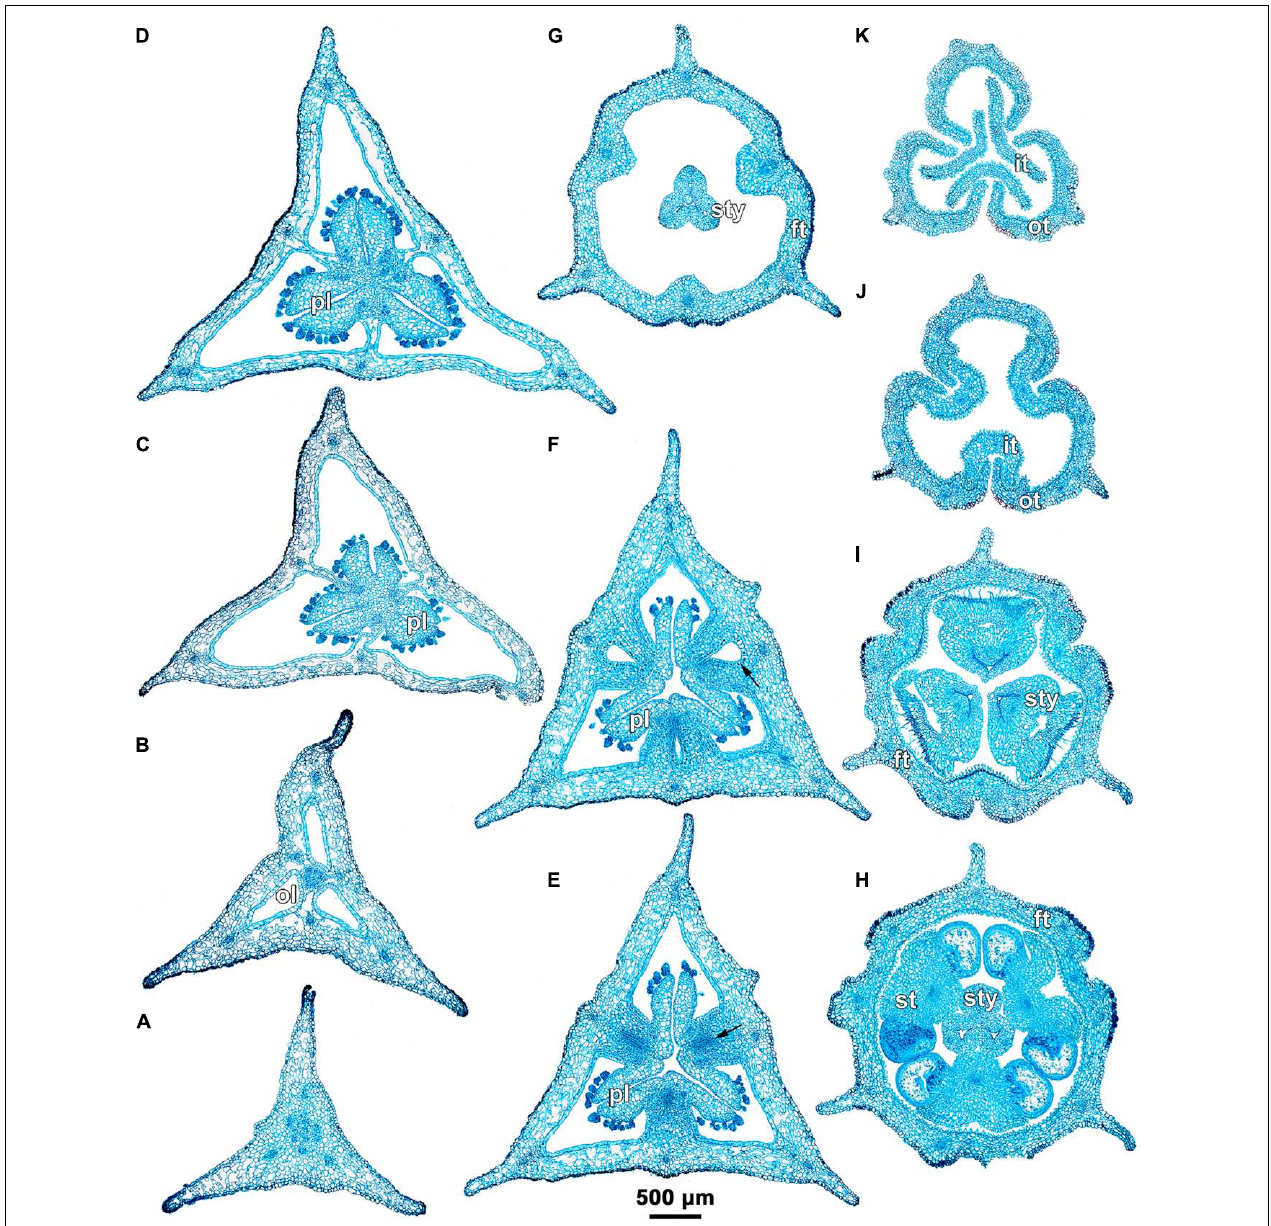
FIGURE 5 | Ascending series of transverse microtome sections of flower bud of Burmannia longifolia (LM). (A) Pedicel just below ovary. (B) Synascidiate zone of ovary. (C,D) Secondarily trilocular portion of symplicate zone of ovary. (E,F) Distal (unilocular) portion of symplicate zone of ovary. (G) Flower at level of common style. (H) Flower at level of anthers and common style. (I) Flower at level of stigmas. (J,K) Outer and inner tepal lobes. Arrow indicates septal nectary. ft, floral tube; it, inner tepal; ol, ovary locule; ot, outer tepal; pl, placenta; st, stamen; sty,